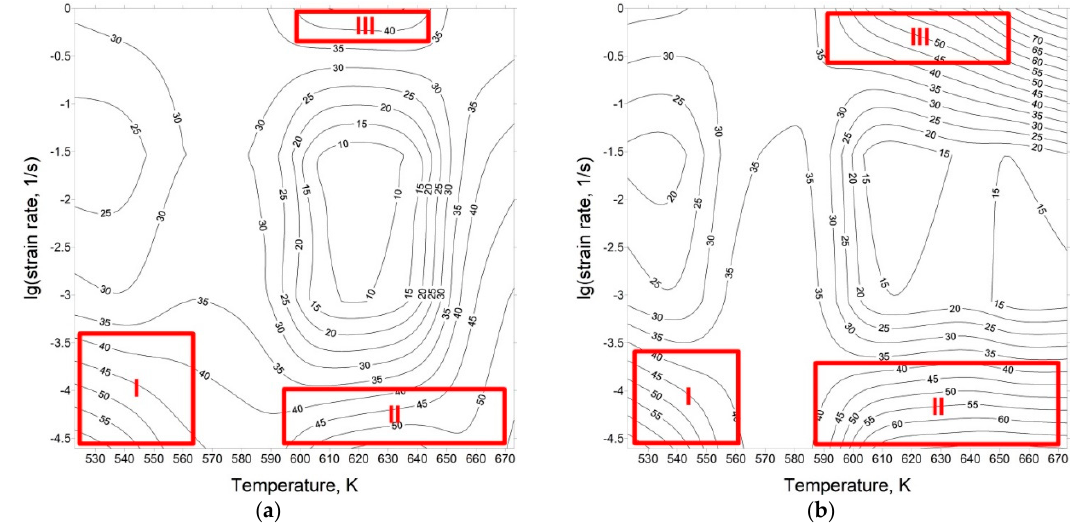
Figure 9. The processing maps of the Mg–4.5 Li–1.5 Al + 0.2 TiB alloy at a strain of ( a ) 0.3 and ( b ) 0.6; the contour numbers indicate the percentage efficiency of power dissipation ( η %).